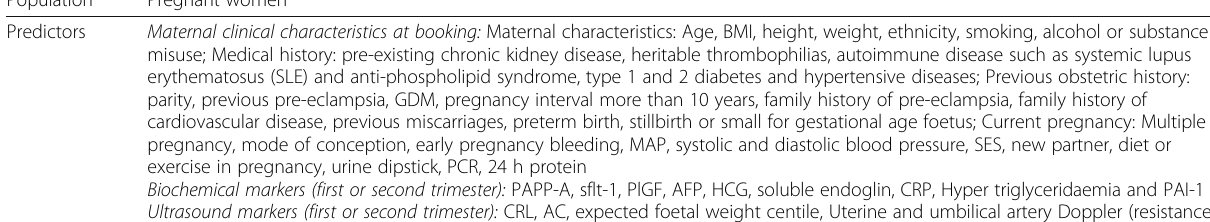
Table 1 Characteristics of population, predictors and outcome in the IPD meta-analysis on prediction of pre-eclampsia Population Pregnant women Predictors Maternal clinical characteristics at booking: Maternal characteristics: Age, BMI, height, weight, ethnicity, smoking, alcohol or substance misuse; Medical history: pre-existing chronic kidney disease, heritable thrombophilias, autoimmune disease such as systemic lupus erythematosus (SLE) and anti-phospholipid syndrome, type 1 and 2 diabetes and hypertensive diseases; Previous obstetric history: parity, previous pre-eclampsia, GDM, pregnancy interval more than 10 years, family history of pre-eclampsia, family history